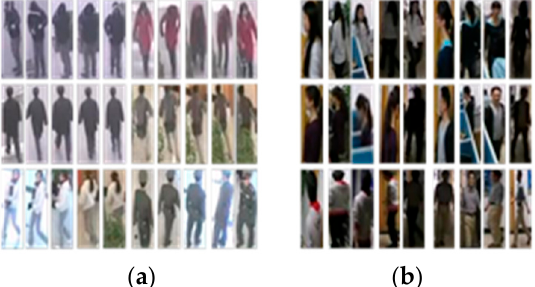
Figure 2. Some examples of the training data. The images in ( a ) are from subset1 of NLPR_MCT dataset, and images in ( b ) are from subset3 of NLPR_MCT dataset.